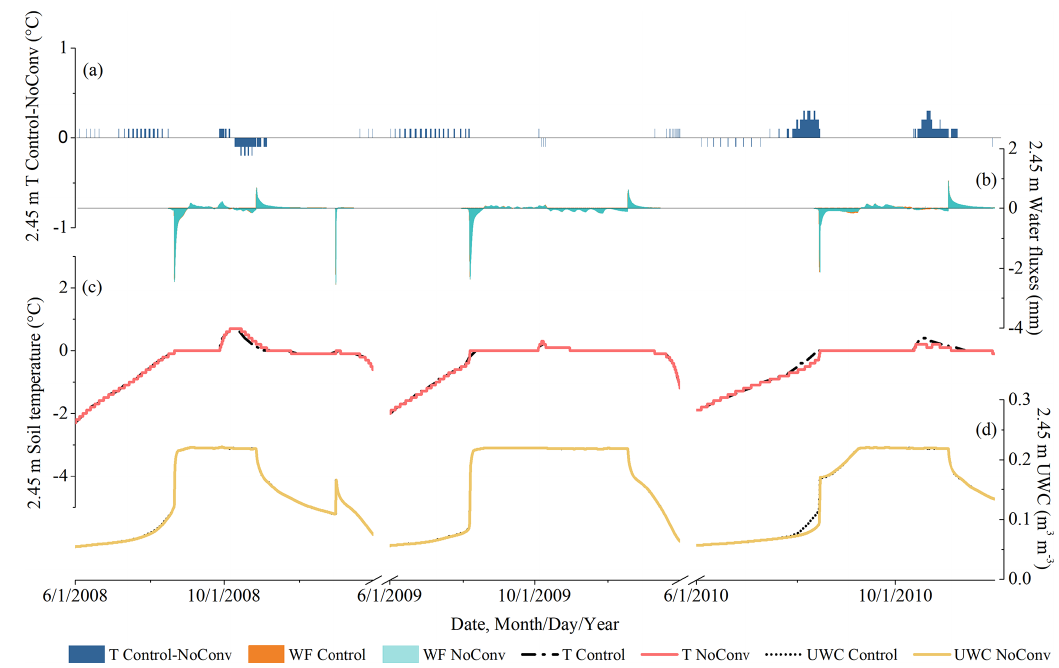
Figure 11. Hourly soil temperature, water flux, and UWC at 2.45m depth simulated under NoConv and Control during the 2008–2010 thaw periods. The same notations as in Fig. 7 are